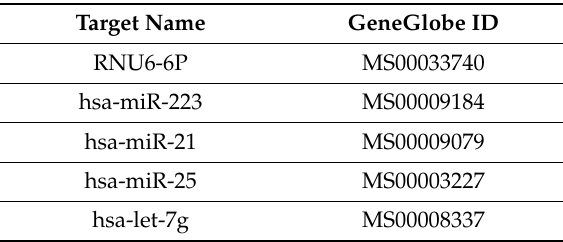
Table 1. Qiagen GeneGlobe IDs of microRNA (miRNA) target sequences.